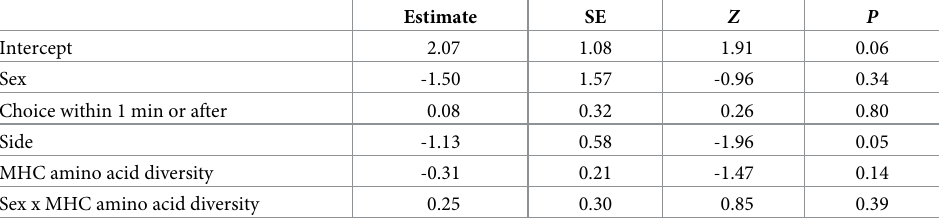
Table 1. Model for bird choice in relation to: The number of MHC- I amino acid alleles of a potential partner (as a dichotomous variable: Greater MHC amino acid diversity (yes) vs. lower number of MHC amino acid diversity). Estimate SE Z P Intercept 2.07 1.08 1.91 0.06 Sex -1.50 1.57 -0.96 0.34 Choice within 1 min or after 0.08 0.32 0.26 0.80 Side -1.13 0.58 -1.96 0.05 MHC amino acid diversity -0.31 0.21 -1.47 0.14 Sex x MHC amino acid diversity 0.25 0.30 0.85